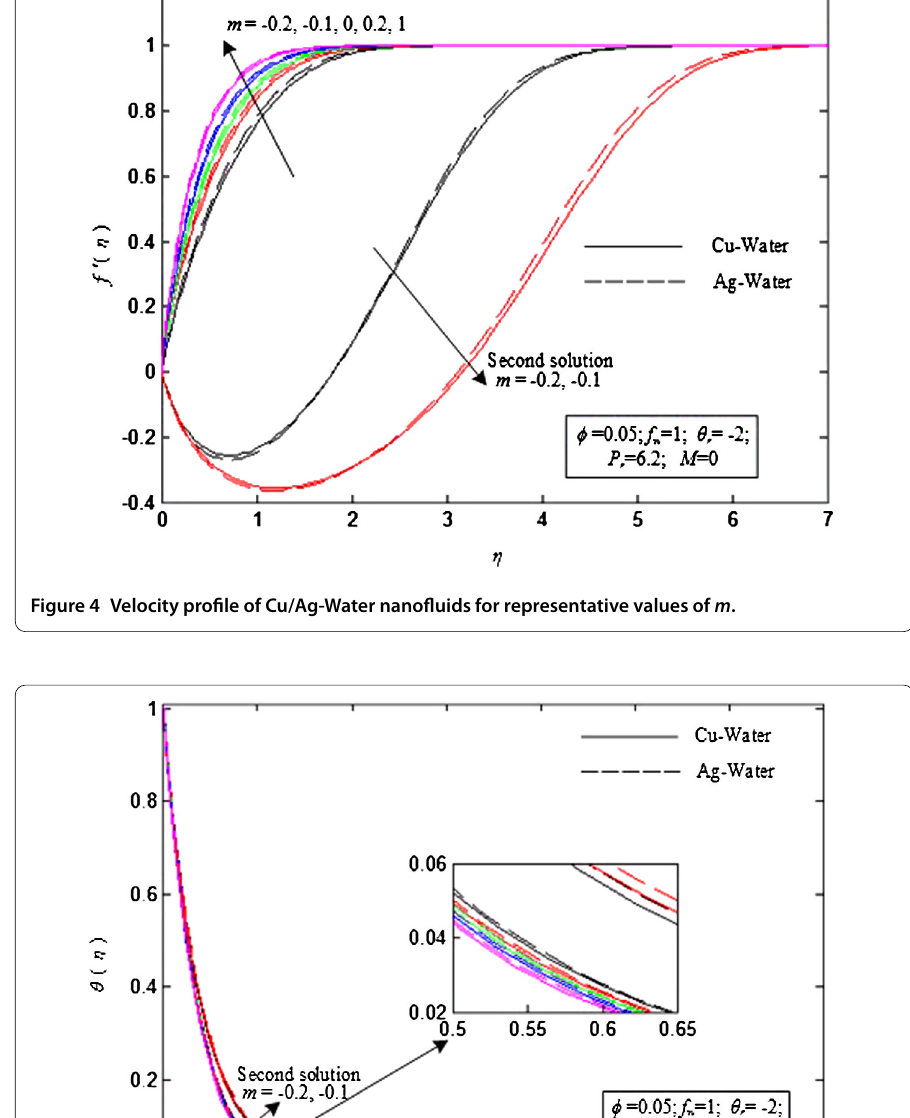
that the influence of pressure gradient parameter m on the temperature profiles is much less than that on velocity profiles for the two nanofluids. Also, the temperature of Cu- Water nanofluid is slightly lower than that of Ag-Water nanofluid for each fixed m . It is worth noting that dual solutions also exist in the temperature profiles for decelerated flows ( m <